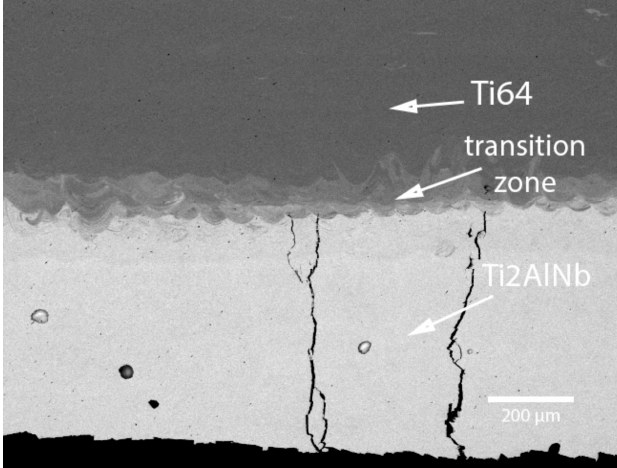
Figure 4. BSE image of the bimetallic sample produced without platform preheating (Type A).